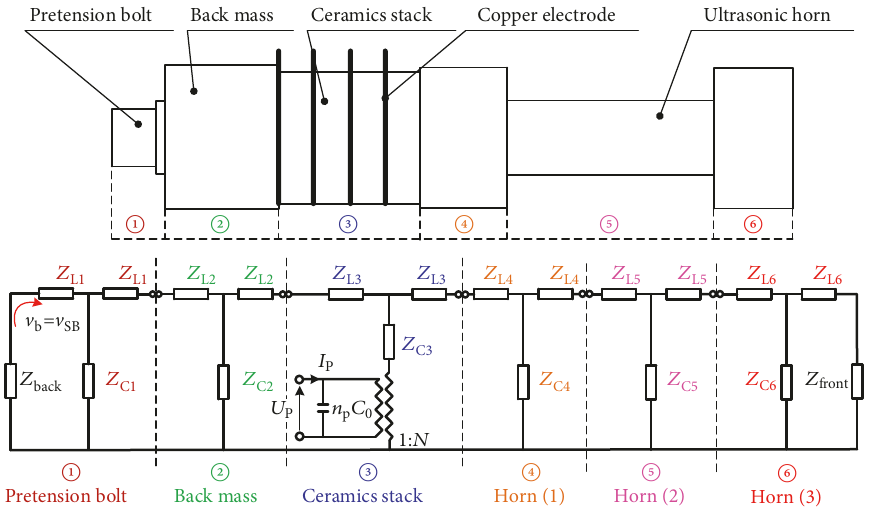
Figure 3: Acoustic impedance model of the ultrasonic drill’s